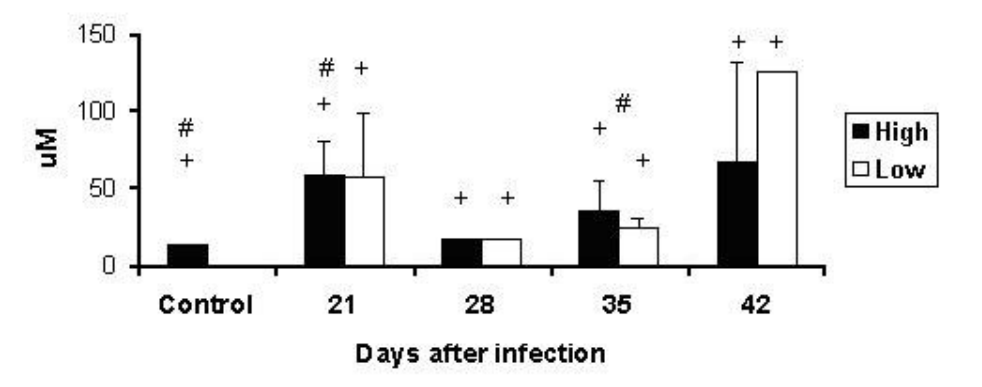
Figure 6. Production of NO ( μ M) in supernatants from culture of peritoneal macrophages of High and Low antibody producer (Selection IV-A) mice infected with Mycobacterium bovis- AN at different periods, compared with their respective 5 controls.